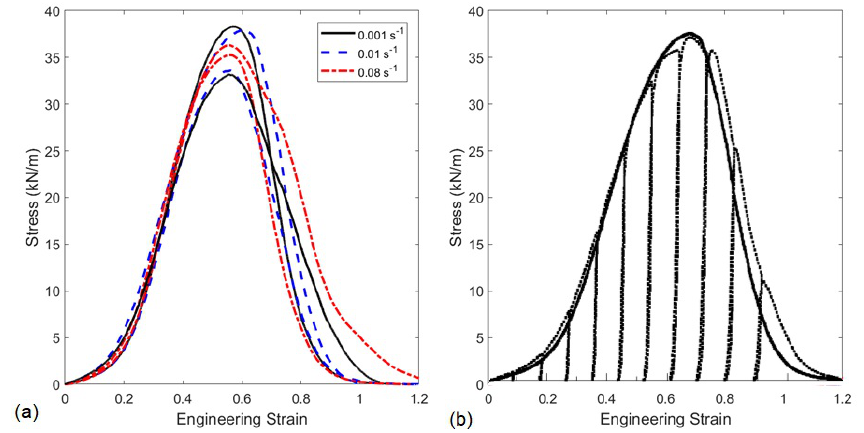
Figure 3. ( a ) Representative nominal stress vs. engineering strain curves for quasi-static strain rates. ( b ) Comparison between monotonic and cyclic deformation [15].